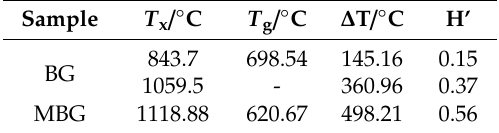
Table 5. Characteristic temperature and stability parameter of the BG and MBG measured at 10 ◦ C / min.